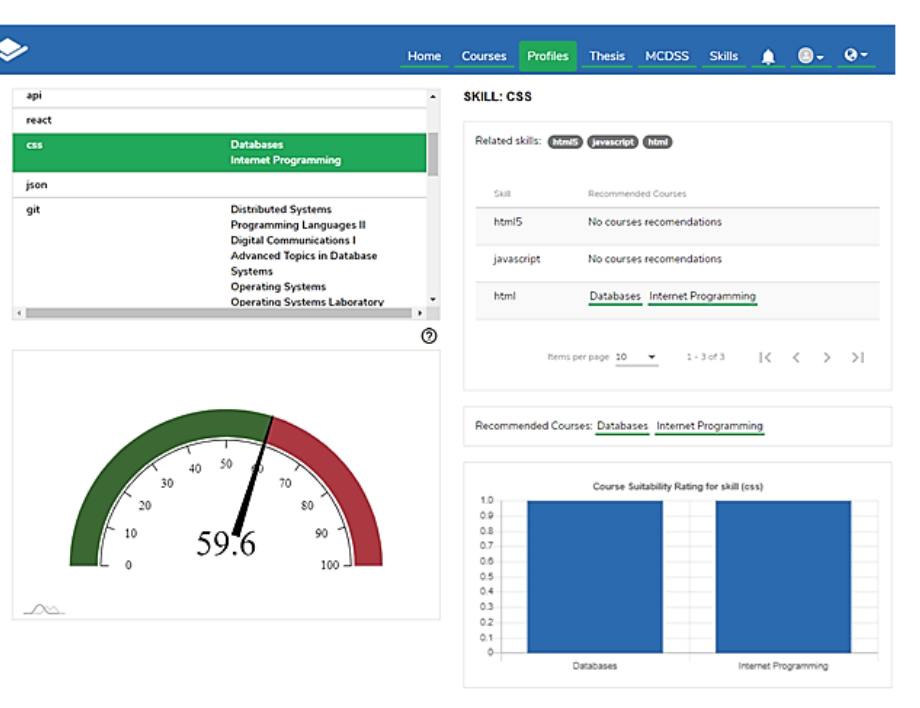
Figure 8. Bipartite comparison between courses.